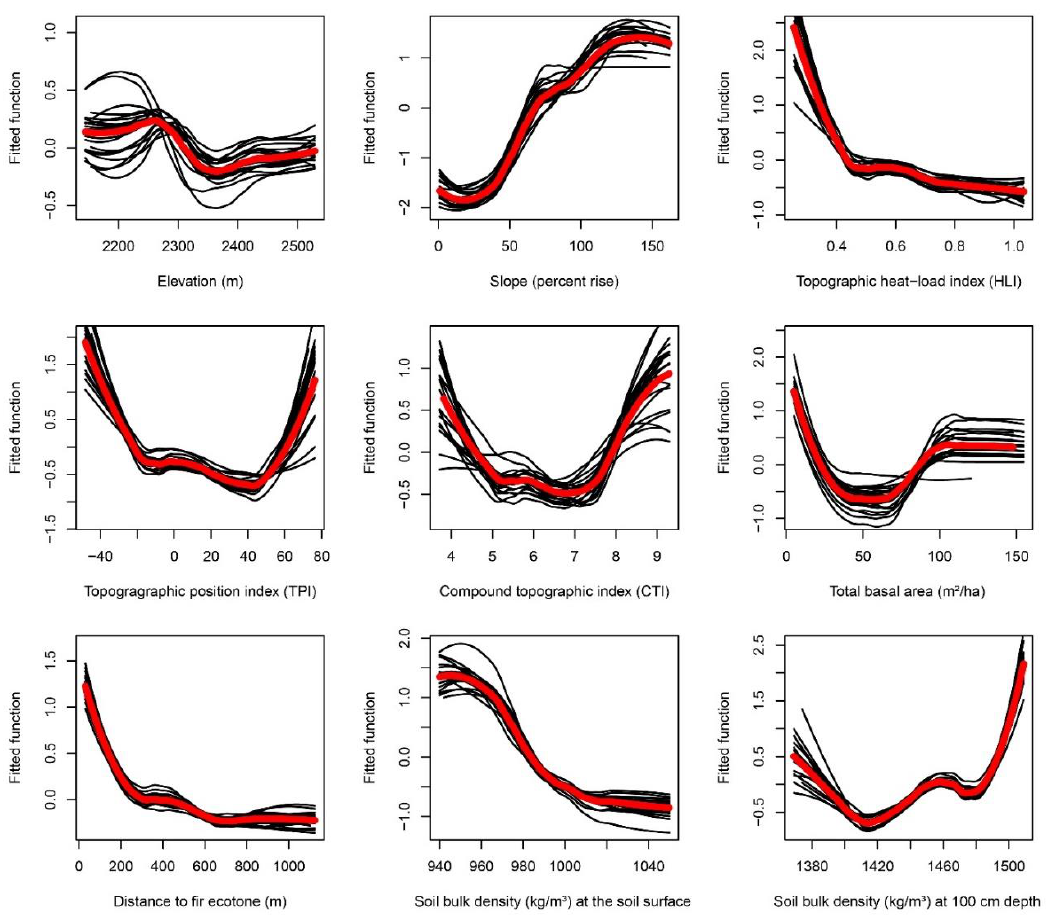
Figure A7. Partial-dependence plots from boosted regression tree models of refugia from drought and mountain pine beetle impacts in whitebark pine areas in 2009. Black lines represent loess-smoothed partial-dependence relationships from 20 independent bootstrapped model runs using a random subsample of n = 2000 grid cells for each model run. Red lines indicate means across 20 bootstrapped model runs. In all plots, higher values on the vertical axis represent greater prevalence of refugia.